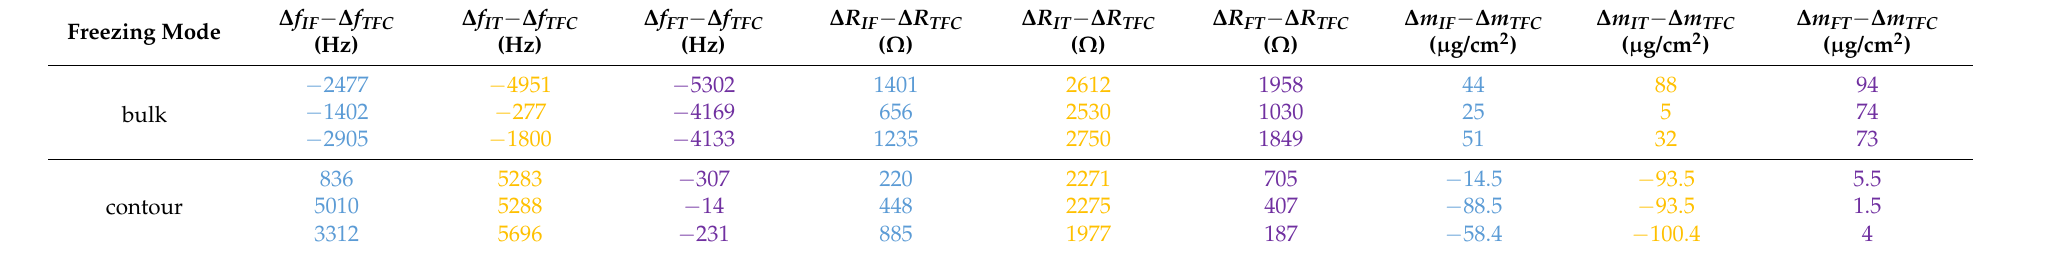
Table 2. Actual sensor response reflecting the water droplet’s freezing and thawing (after subtracting the temperature